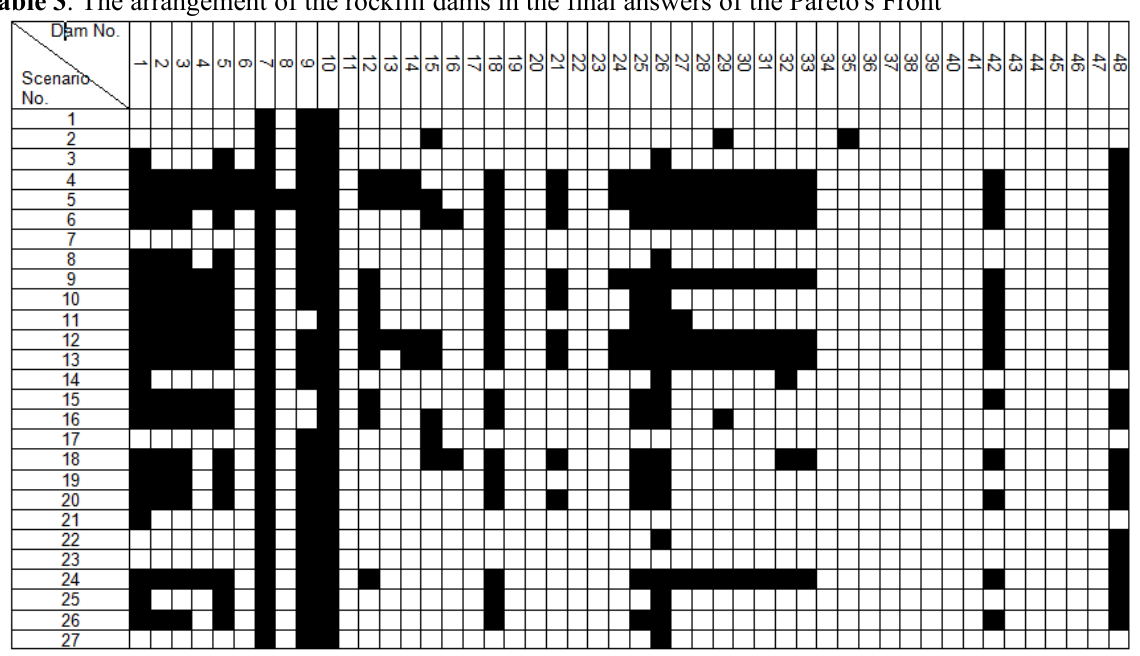
Table 3 . The arrangement of the rockfill dams in the final answers of the Pareto's